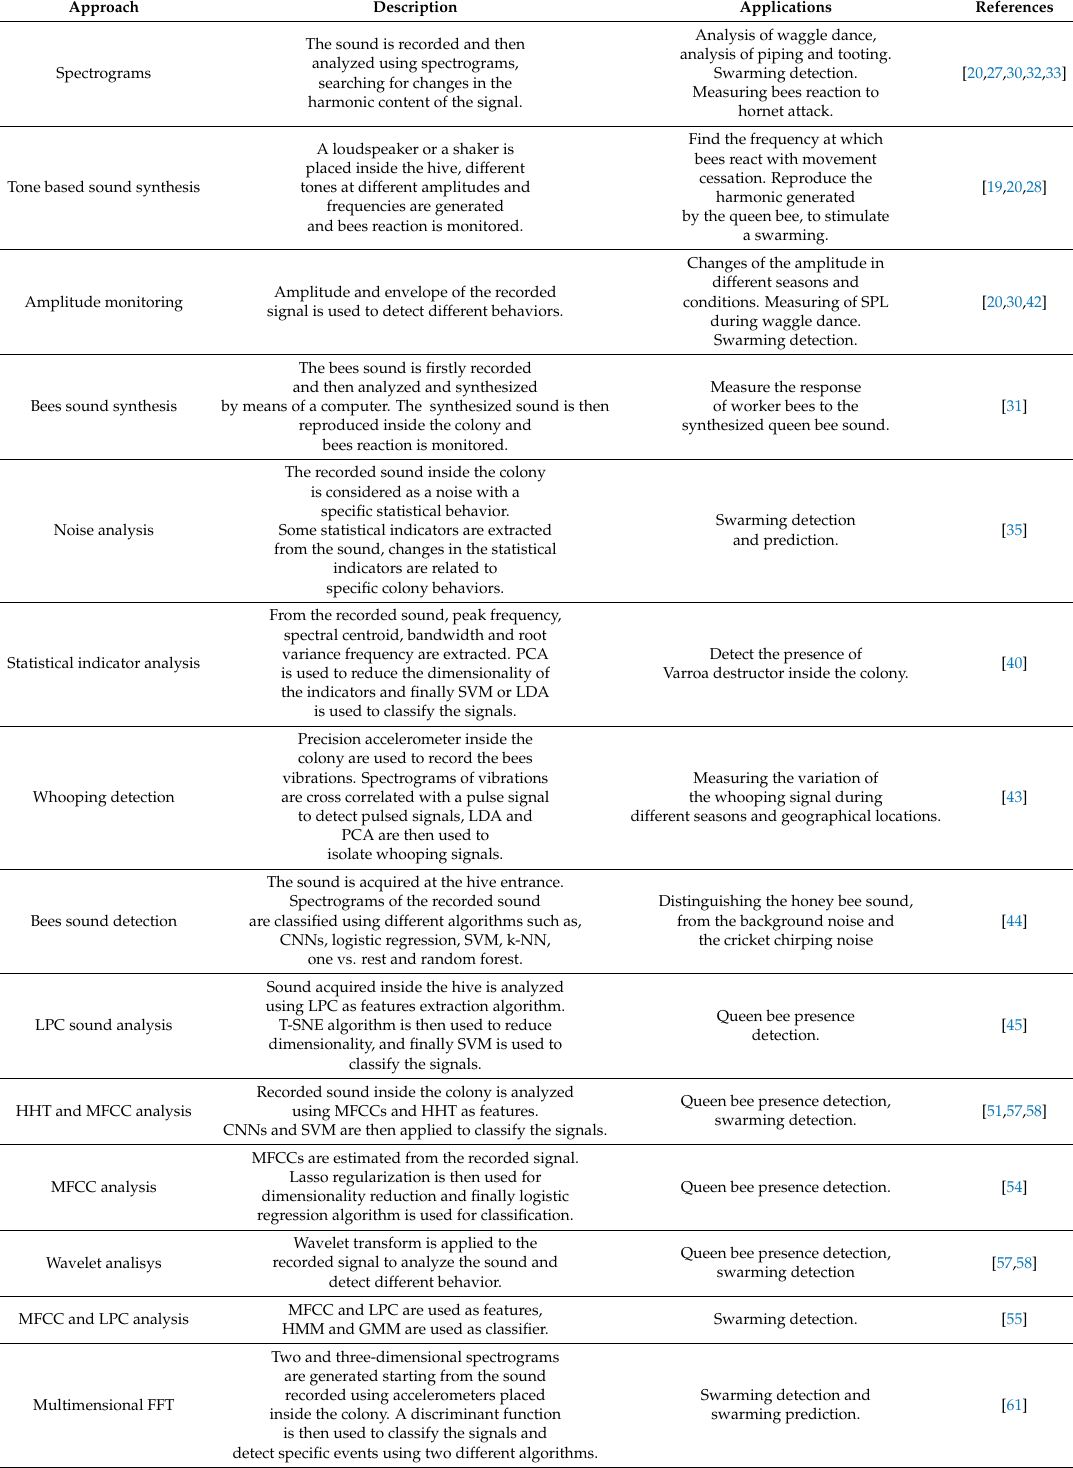
Table 1. Summary of the state-of-the-art of approaches discussed in this work.